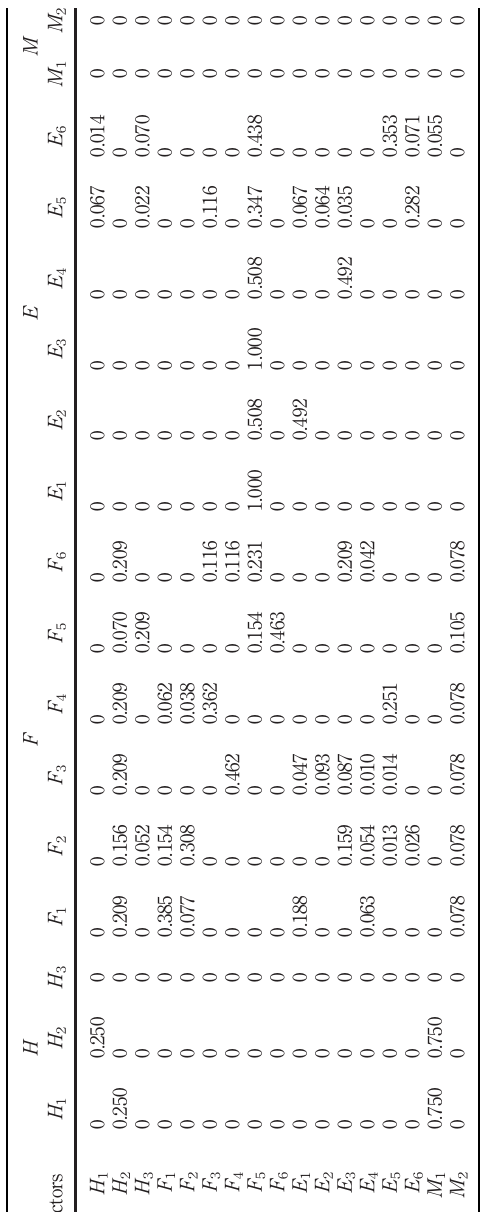
Table 5. Weighted overrun super matrix of secondary risk factors relative to primary risk